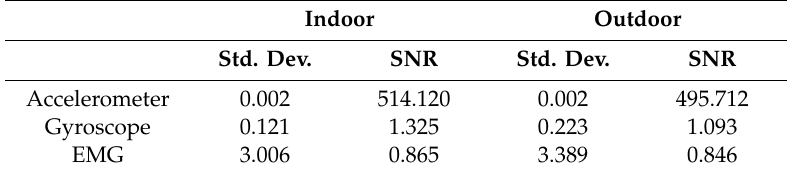
Table 2. Comparison of EMG and IMU data quality between indoor and outdoor for at-rest activity. Indoor Outdoor Std. Dev. SNR Std. Dev.